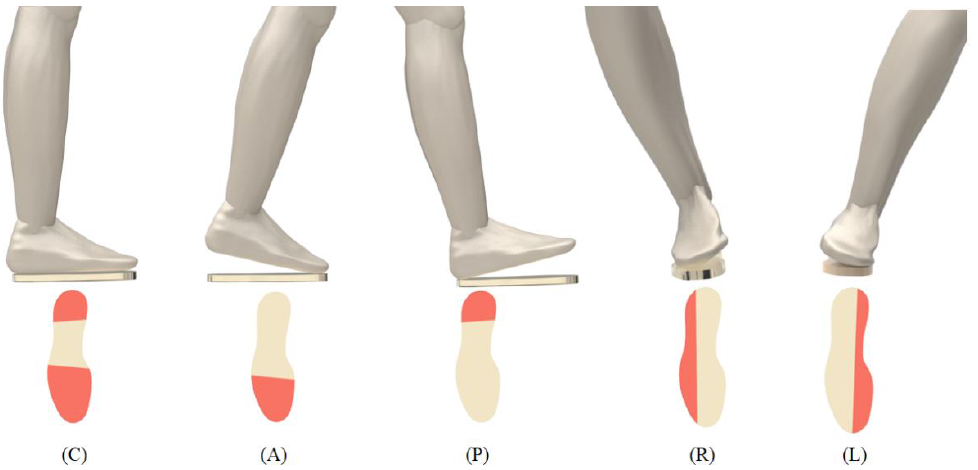
Figure 5. Schematic diagram of the protocol implemented for the analysis of the body center of mass (BCM) displacement and descriptive pressure increasing on the platform (the subject remained in each position for 3 s—the areas with increased pressure are coloured in red).